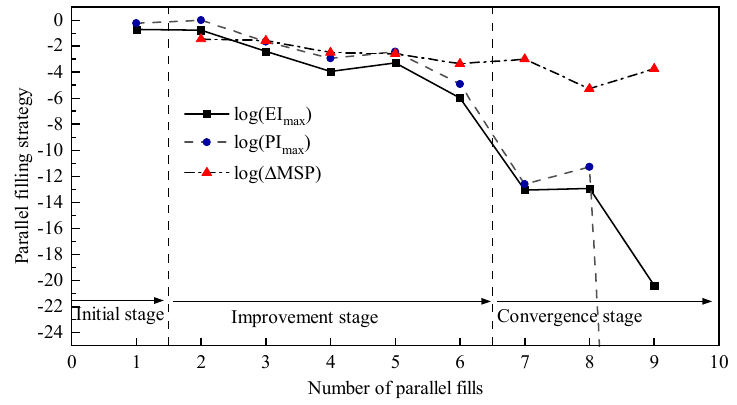
Figure 10. Parallel filling process.